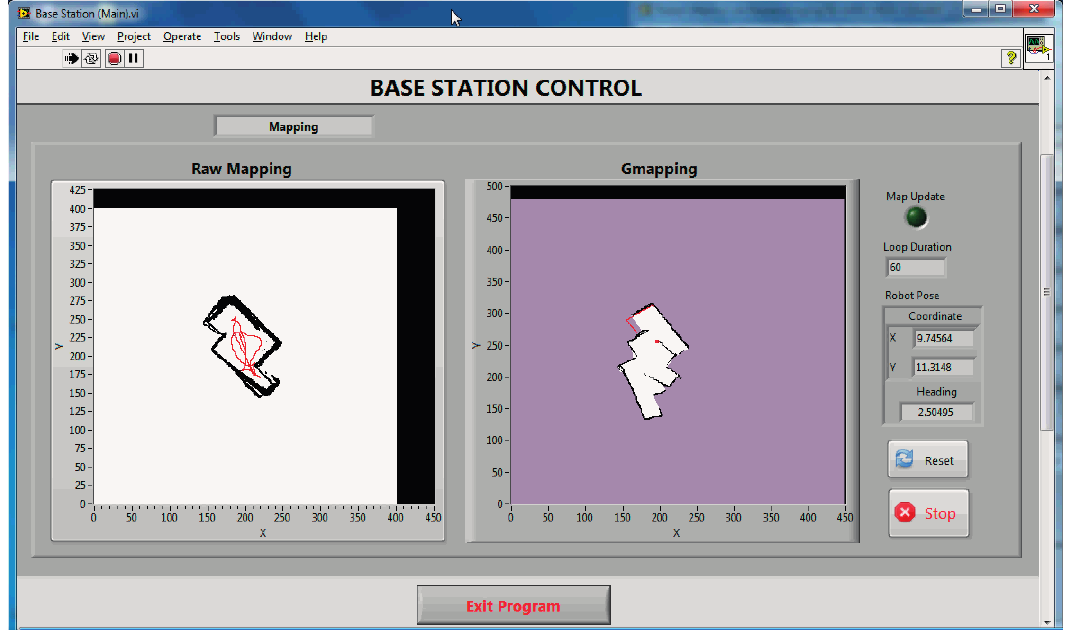
Figure 7. Front panel showing the map of the room in Test